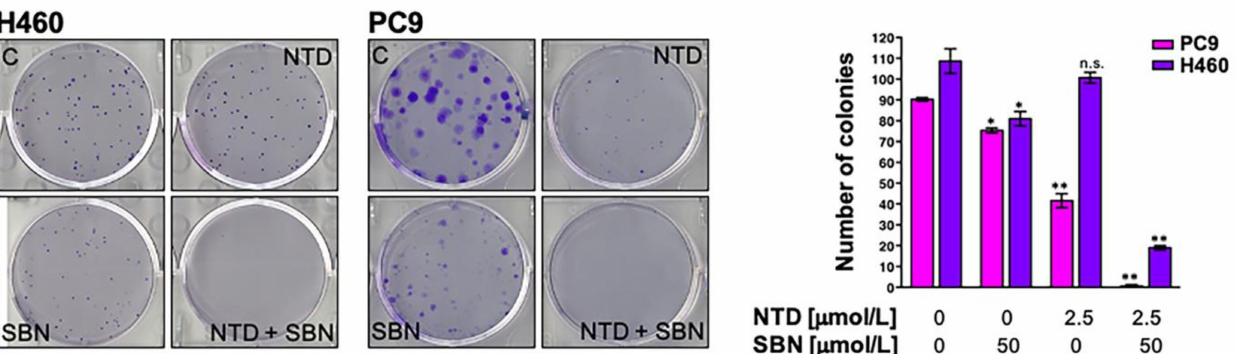
Figure 6. Analysis of clonogenic survival in response to nintedanib plus silibinin. Left. Representative images from 6-well plates of colonies of H460 and PC-9 cells treated with nintedanib and/or silibinin. ImageJ (NIH) was used to quantify the number of 7-day-old colonies stained with crystal violet. Right. Columns and error bars represent mean values and S.D., respectively. Comparisons of means were performed by ANOVA. p values < 0.01 and < 0.001 were considered to be statistically significant (denoted as * and **, respectively; n.s. not